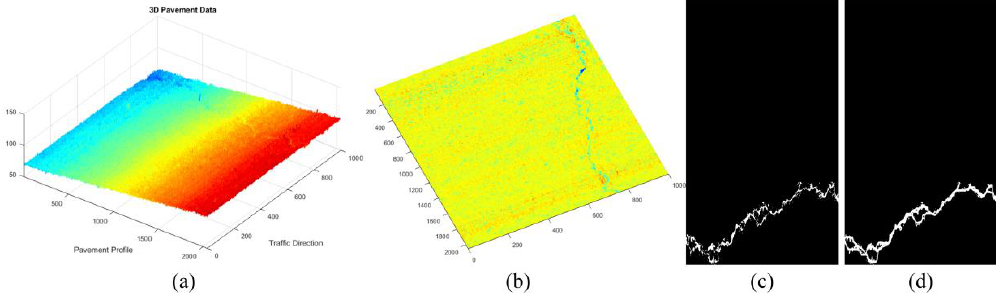
Figure 11. Sparse components and the corresponding pavement traverse cracks information, ( a ) 3D pavement data, ( b ) the corresponding sparse components, ( c ) crack information, ( d ) crack ground truth information.